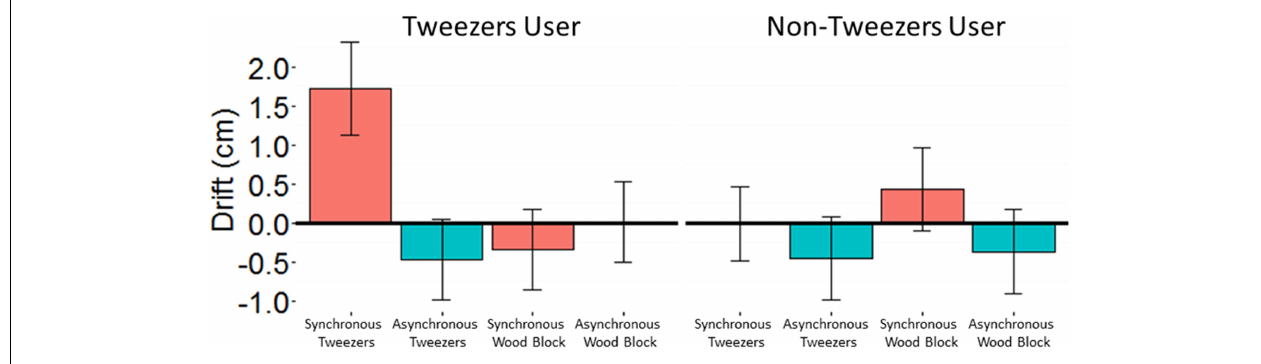
FIGURE 7 | The significant interaction of viewed object, timing of visuo-tactile stimulation and the median split of self-report of tweezers-use. Error bars represent ± 1 SEM.